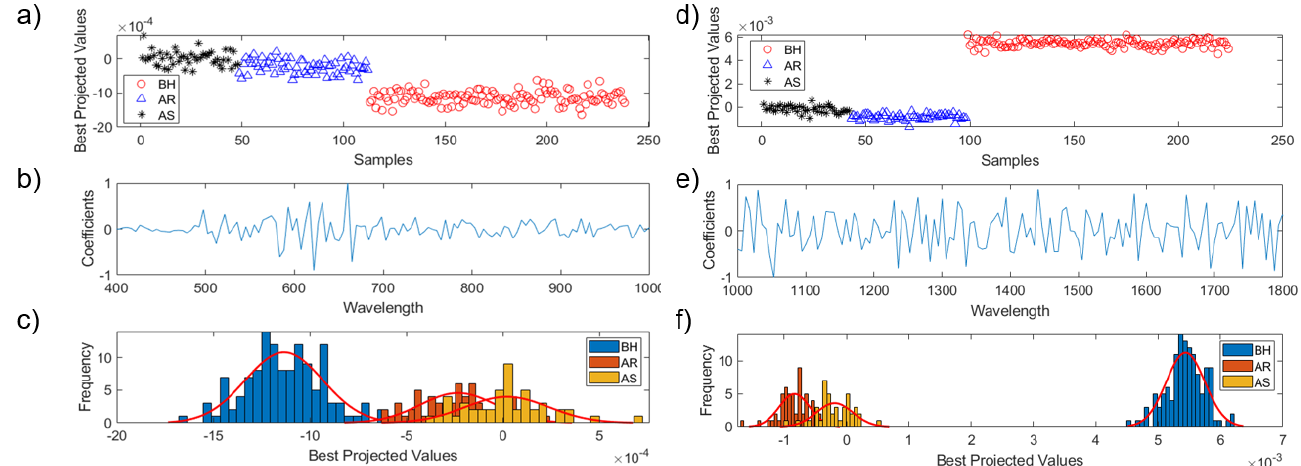
Figure 4. Averaged spectra of LDA results of Vis/NIR ( a – c ) and SWIR ( d – f ) of control and stressed ginseng plants. BH, before exposed to heat stress; AR, after exposed to heat stress group about resistibility; AS, after exposed to heat stress group about susceptibility.